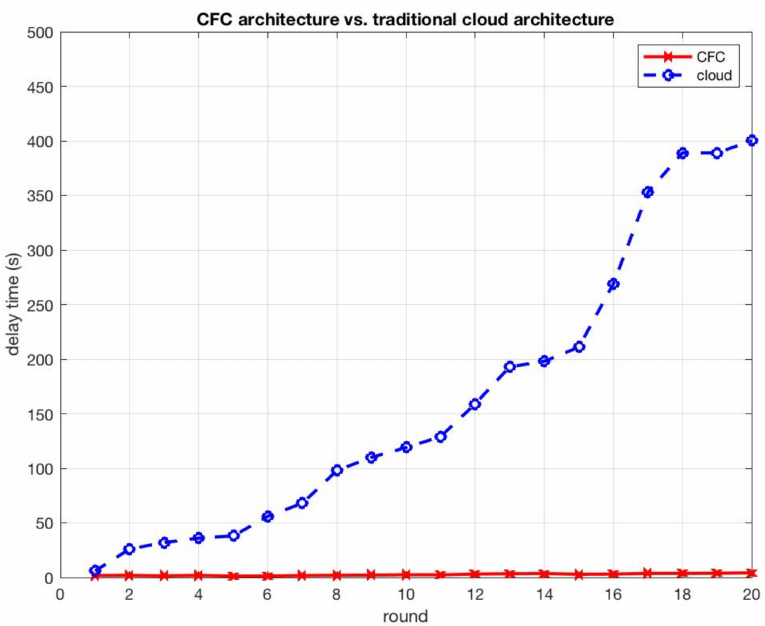
Figure 13. The time delay of newest data query (the proposed architecture vs. traditional cloud).